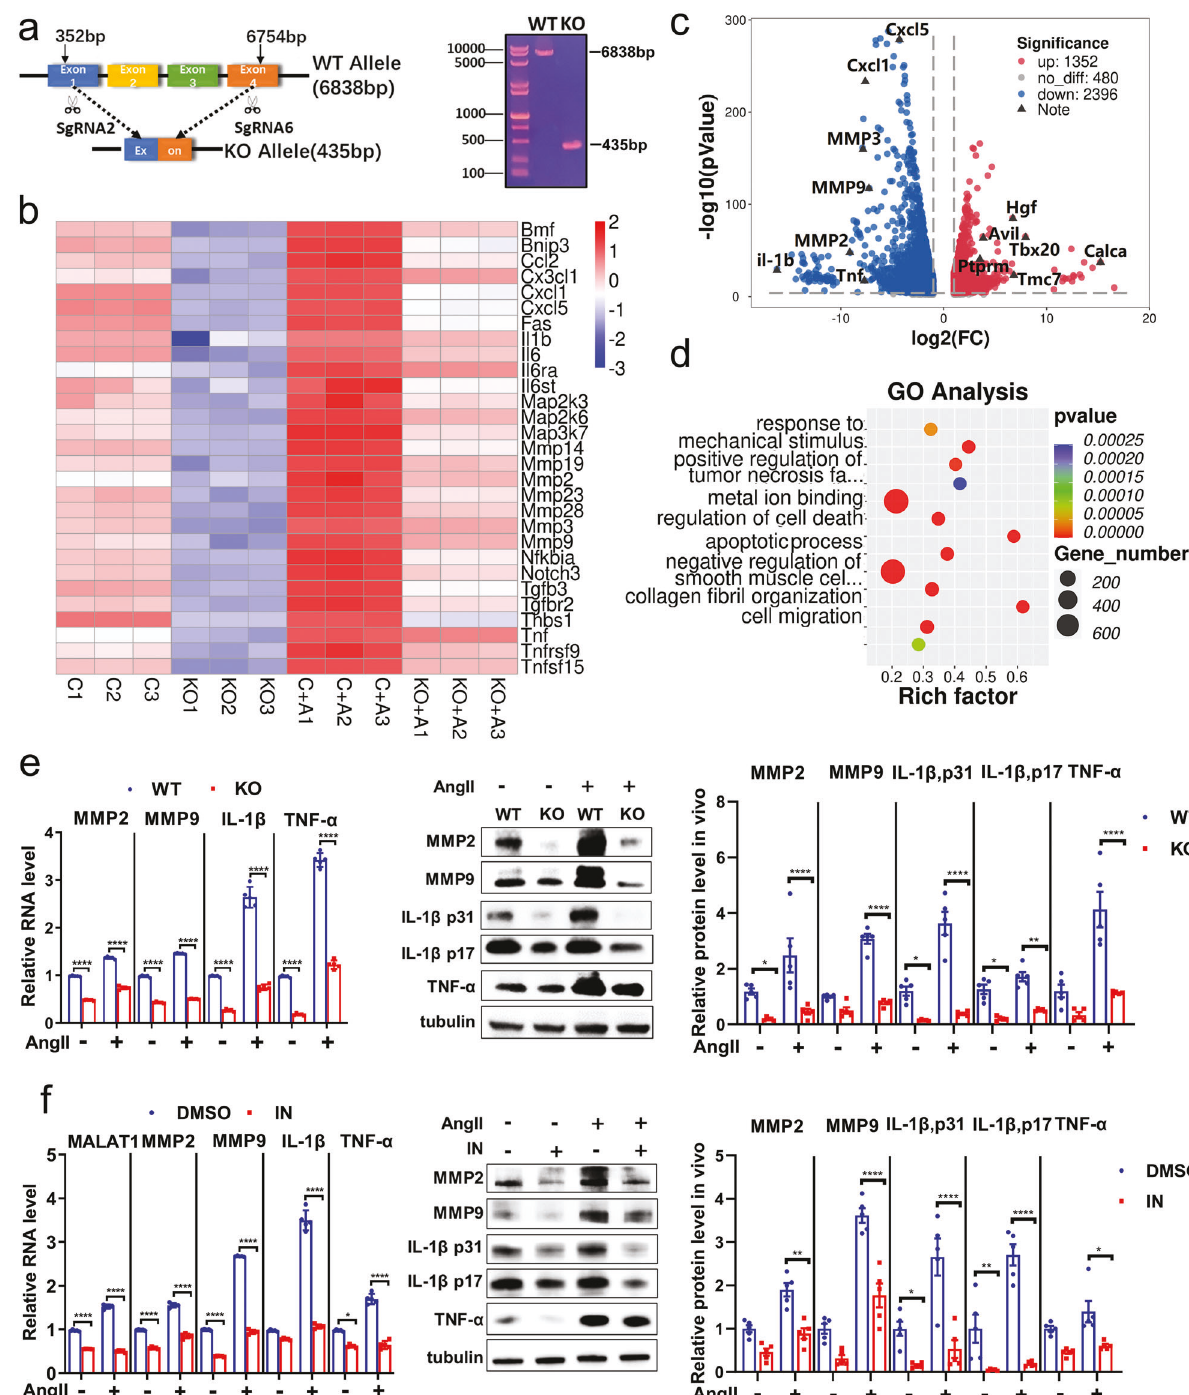
Fig. 6 Inhibiting Malat1 can remarkably protect smooth muscle cells from AngII stimulation in vitro. a The monoclonal MOVAS cells with stable knockout of the Malat1 gene using the CRISPR/Cas9 system via lentiviral transfection were screened. b RNA transcriptome sequencing of Malat1 − / − and WT MOVAS cells at baseline and with AngII stimulation. A heatmap of downregulated genes showed relative expression ( z score) levels of abundantly and differentially expressed genes. c The fold change of all genes with a signi fi cant difference was presented in the volcano plot. d GO analysis of downregulated genes in Malat1 − / − MOVAS cells compared with the WT type. e Qualitative PCR analysis of RNA levels of MMP2 , MMP9 , IL-1 β , and TNF- α in KO and WT MOVAS cells at baseline and with AngII stimulation. n = 5 per group. Corresponding proteins were detected by immunoblotting. n = 5 per group. f The relative RNA levels of Malat1 , MMPs, and in fl ammatory factors were detected in DMSO and MALAT1-IN-1 groups administered Ang II. n = 5 per group. Corresponding proteins were detected by immunoblotting. n = 5 per group. Data were presented as mean ± SEM and normal distributions were tested by the Shapiro – Wilk method, which showed that all data were normally distributed. Two-way ANOVA followed by Sidak post hoc test used for ( e , f ). * P < 0.05, ** P < 0.01, *** P < 0.001, **** P < 0.0001. Each experiment was repeated independently for a minimum of three times